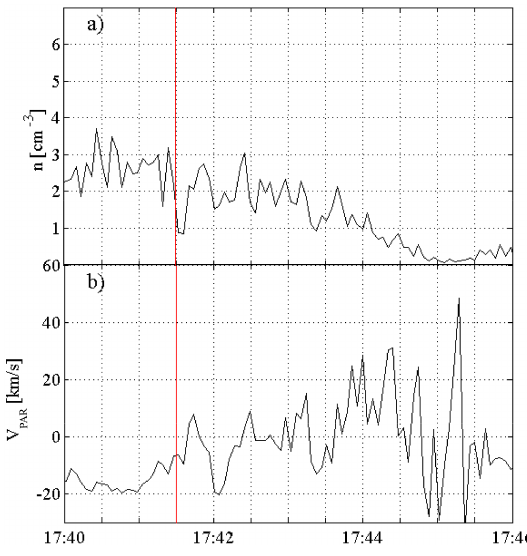
Figure 5. Cluster 4 oxygen on 24 June 2009: (a) density, (b) GSE velocity along the magnetic field; red line indicates the end of area where oxygen ions travel from the ionosphere.